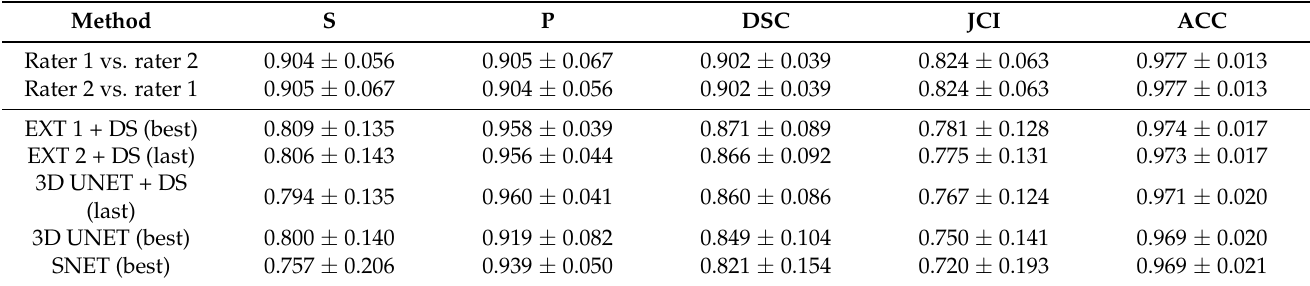
Table 4. Effectiveness of the proposed follicle detection methods compared to the state-of-the-art and inter-rater variability, calculated on the ‘voxel level’, where it is not considered to which follicle the voxel belongs. Presented are the mean and Standard Deviation of Sensitivity or Recall (S), Precision (P), Dice Similarity Coefficient (DSC), Jaccard Index (JCI), and the Accuracy (ACC) on the USOVA3D database.